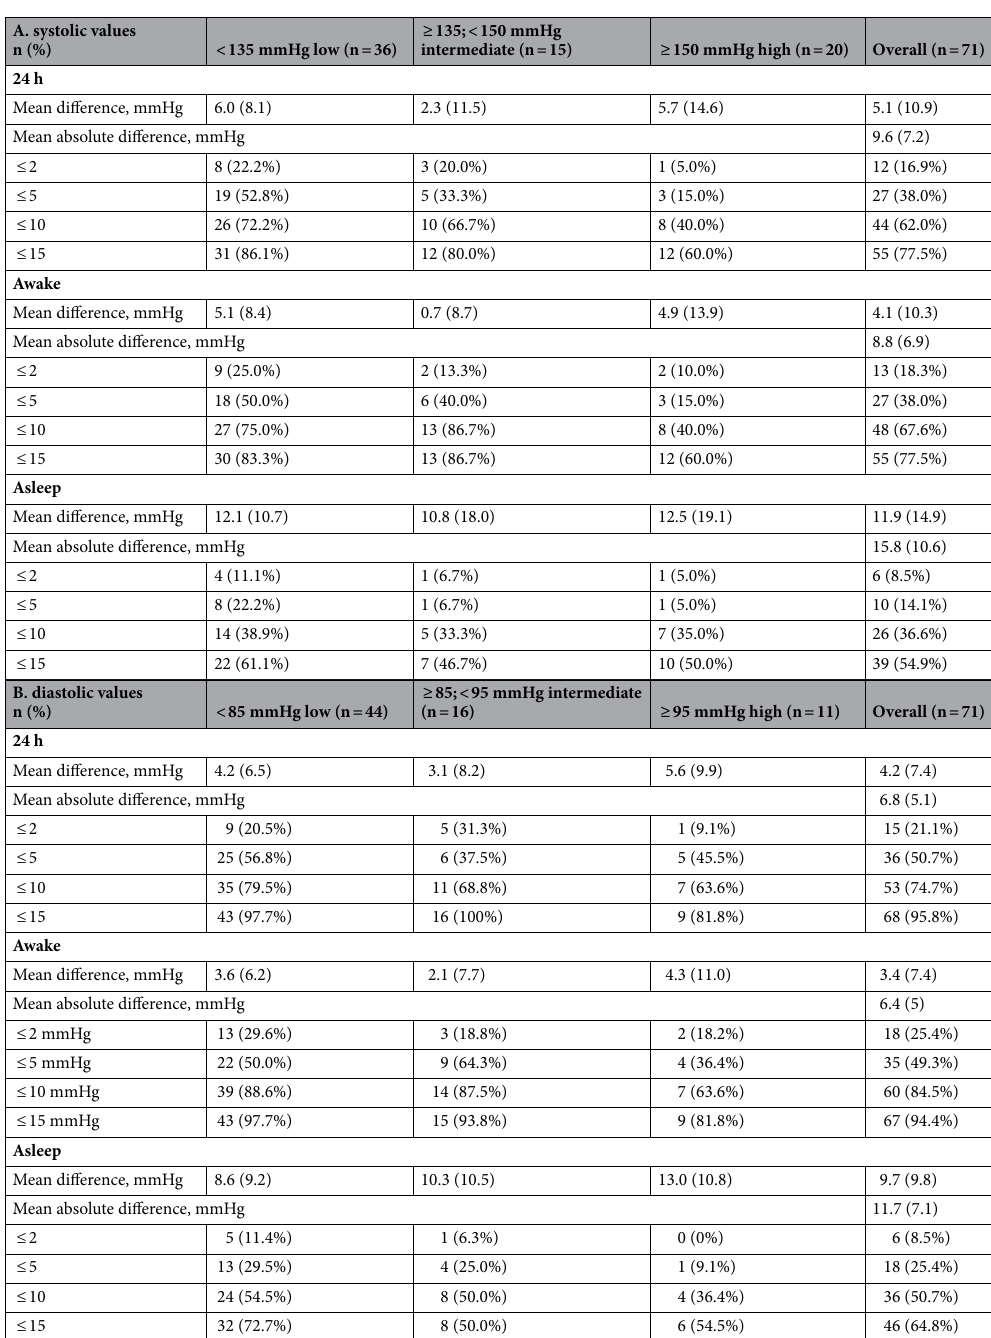
Table 5. Agreement between RefBP and TestBP-V1.5 for mean systolic (panel A) and diastolic (panel B) 24 h, awake and asleep blood pressure values, stratified by mean systolic daytime blood pressure and mean diastolic awake blood pressure respectively. Data are mean (± standard deviation) or counts